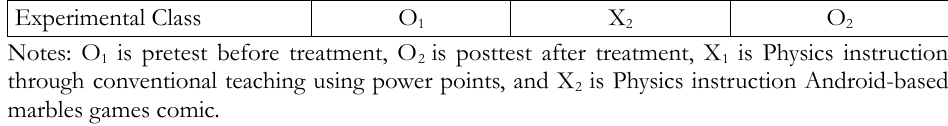
Table 2. Research